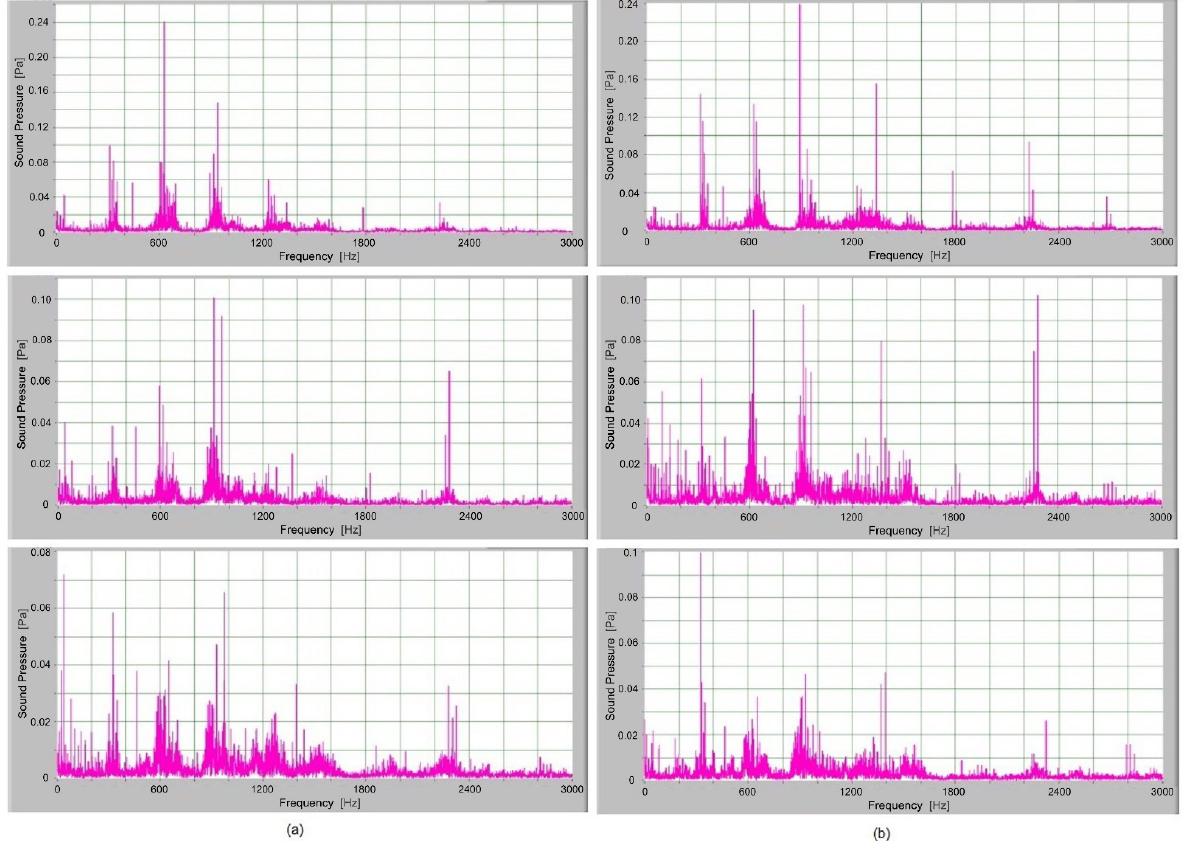
Figure 8. Frequency spectrum of sound pressure for gears loaded with torque 1.5 Nm, 1.3 Nm